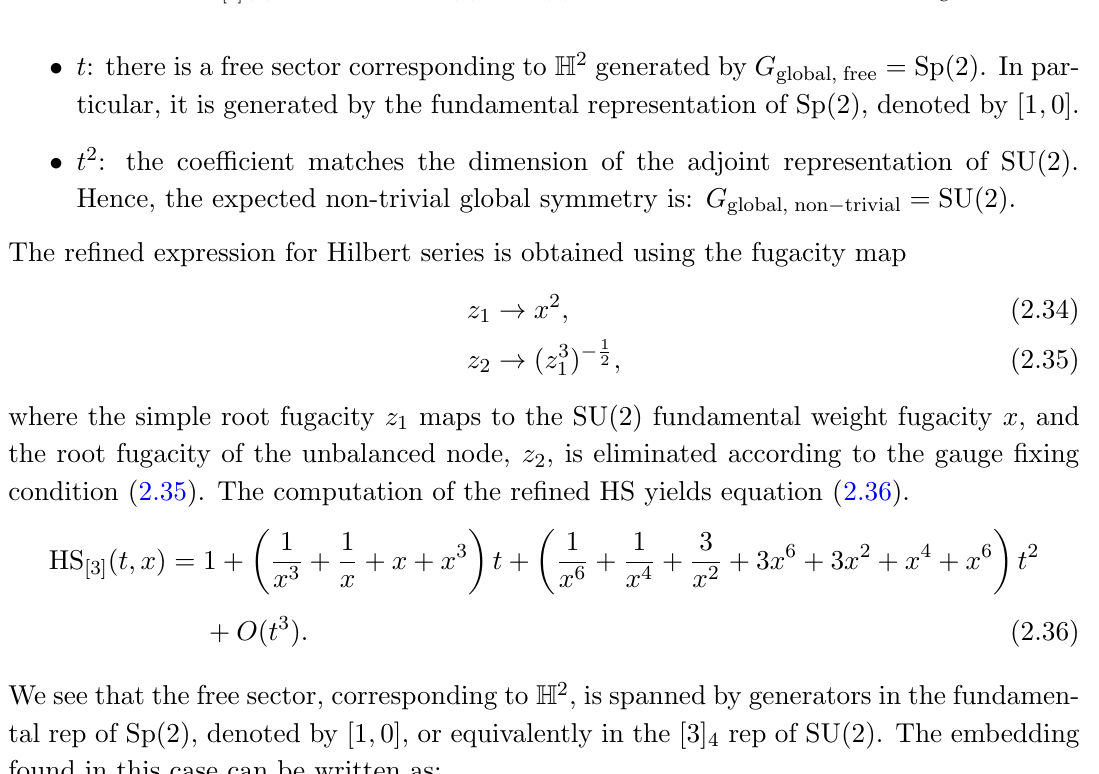
Figure 9 . P (3) quiver with SU(2) (cid:26) Sp(2) global symmetry, b = (cid:0) 1, dim M H [3]